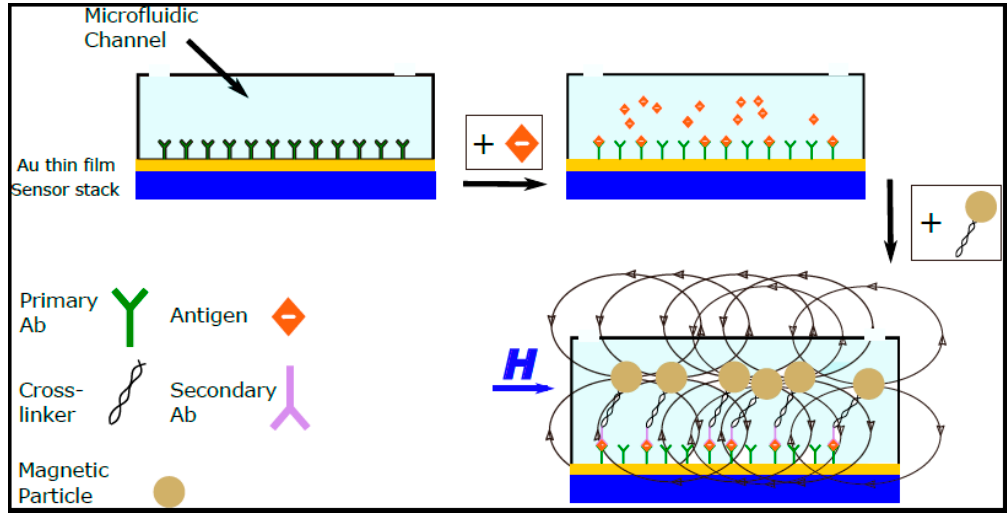
Figure 1. Schematic of the working principle of a standard magnetic biosensor.